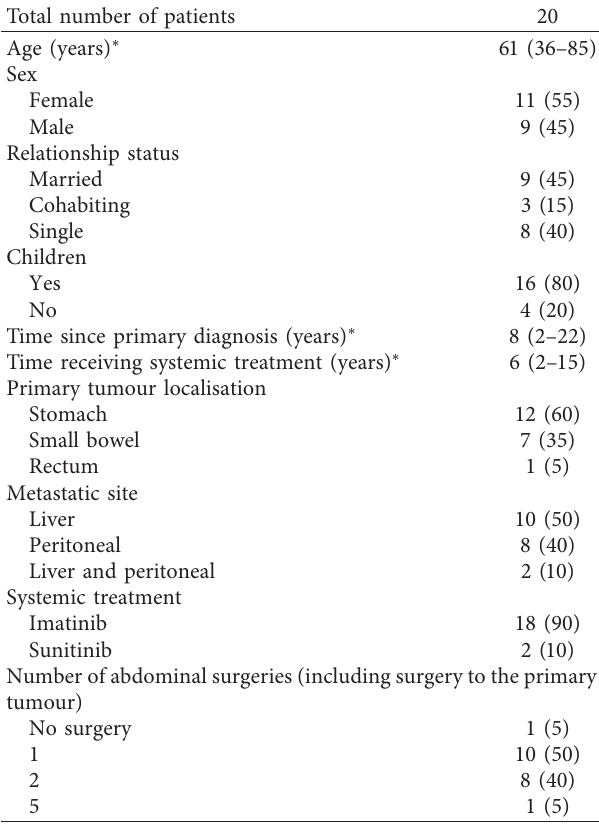
Values in parentheses are percentages unless otherwise indicated. ∗ Values represent the mean